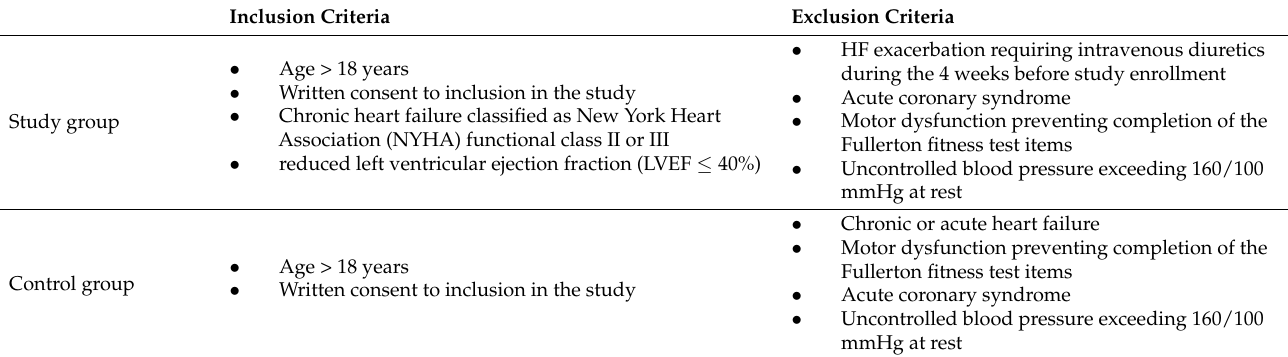
Table 1. Inclusion and exclusion